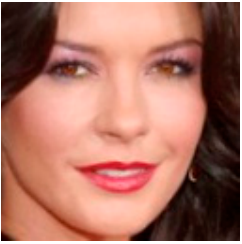
Figure 12. An example photo from the Morph database. Table 17. Recognition results of the Morph photo.